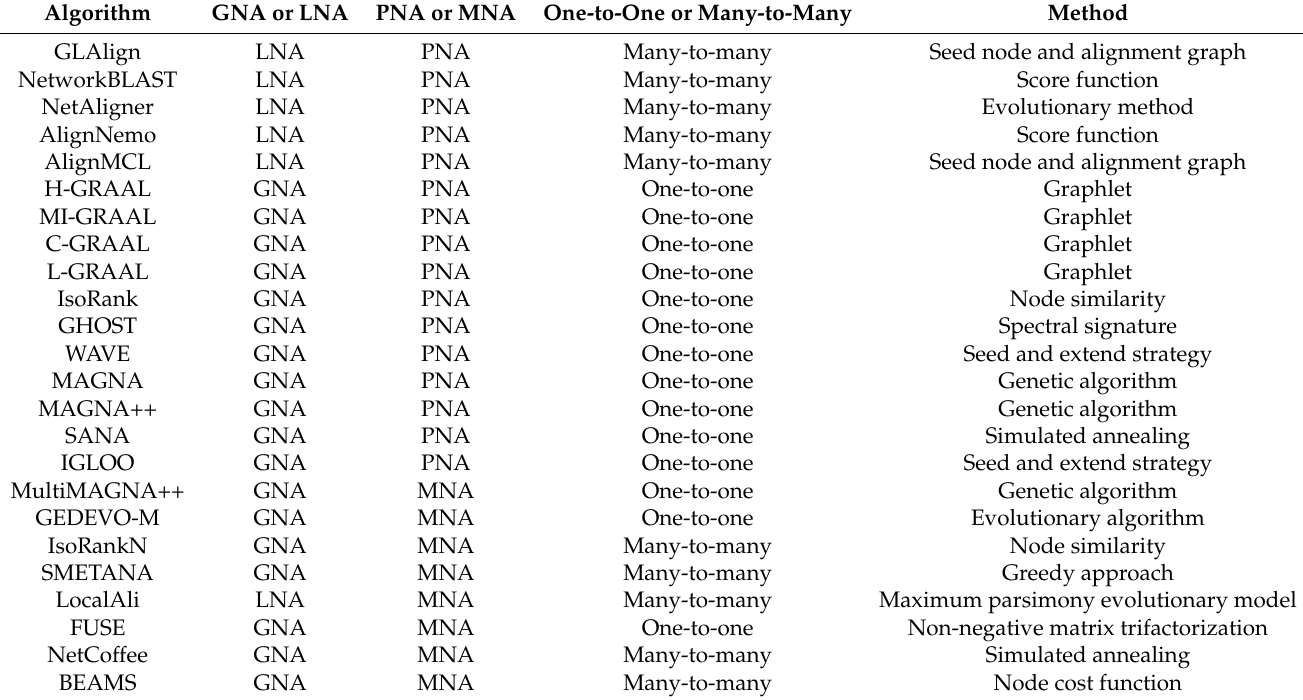
Table 4. PPI Network alignment